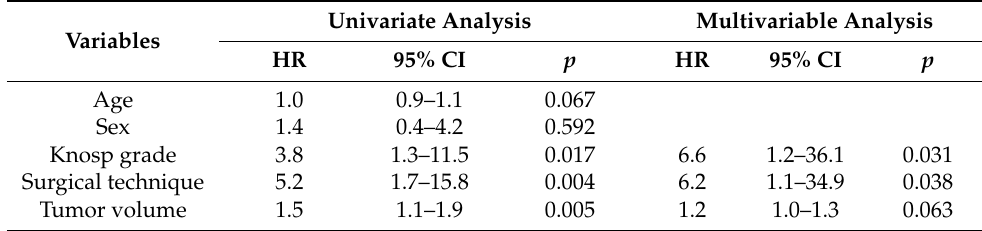
Table 2. Univariate and multivariable analyses of factors with potential impact on gross total resection.